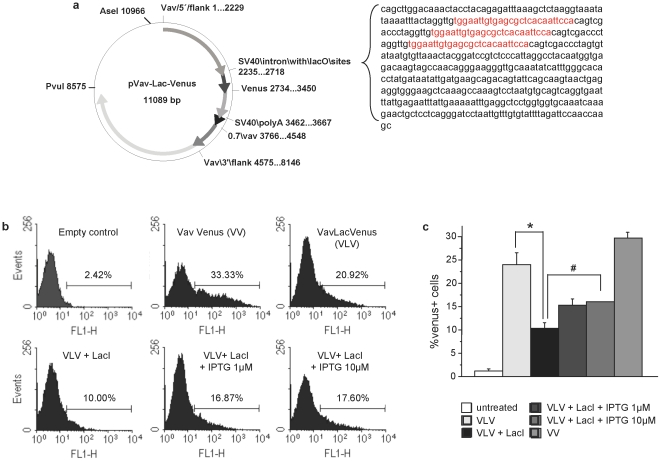
Generation of an IPTG-responsive version of the Vav-transgenic vector.(a) Schematic representation of the modified VavP HS21/45 plasmid (VLV) where three lac repressor binding sites (lacO, sequence in red) were introduced in the SV40 intronic sequence upstream of the multiple cloning site, bearing the Venus cDNA. (b) Functionality of the construct was assessed before oocyte-injection by transient transfection into 293 T cells in the presence or absence of a construct encoding for the lacI repressor followed by flow cytometric analysis. (c) 293 T cells transfected with empty vector, VV, VLV ± lacI were exposed to different doses of isopropyl β-D-1-thiogalactopyranoside (IPTG) and 24 h later the percentage of Venus+ cells was quantified by flow cytometric analysis. Bars represent means ± SEM of a representative experiment performed in triplicate *p<0,01, #p<0.05.